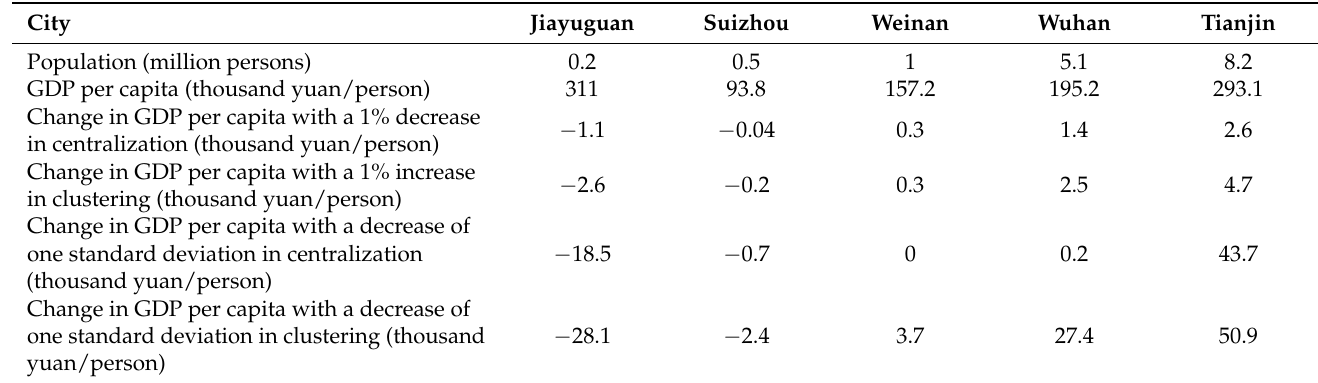
Table 10. Economic benefits of spatial structure in different sized